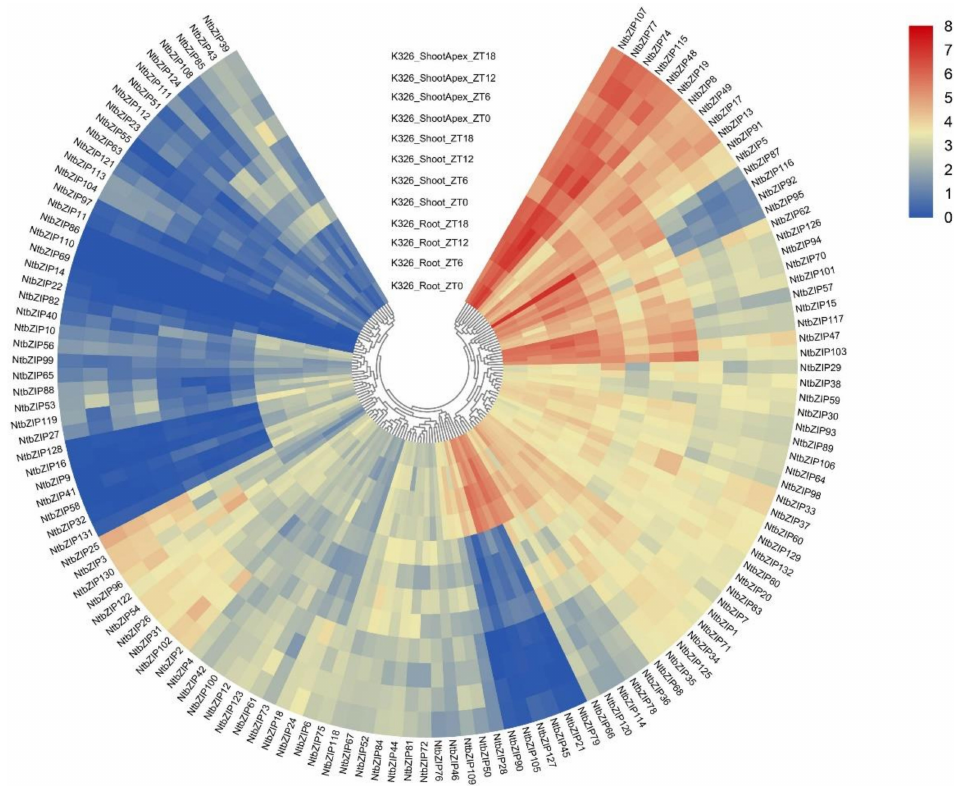
Figure 6. Expression profiles of the NtbZIP genes in three different tissues (root, shoot, and shoot apex). The heatmap was constructed based on the transcriptome data of NtbZIP genes and visualized by